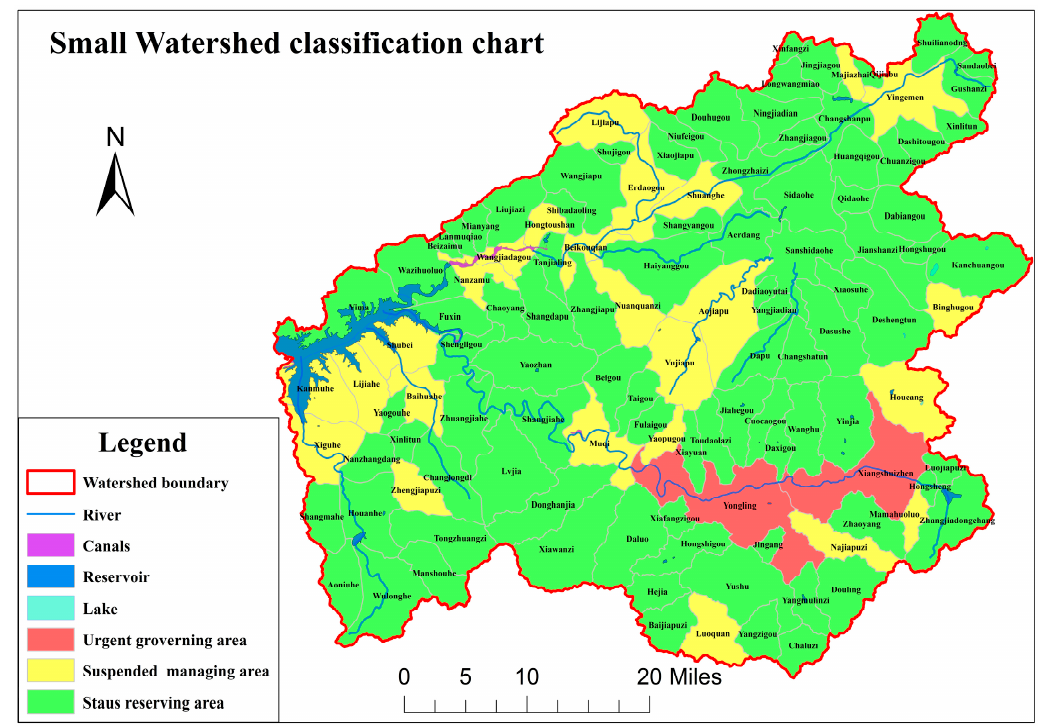
Figure 5. The distribution map of the K-means clustering analysis result in the upstream of the Dahuofang reservoir.